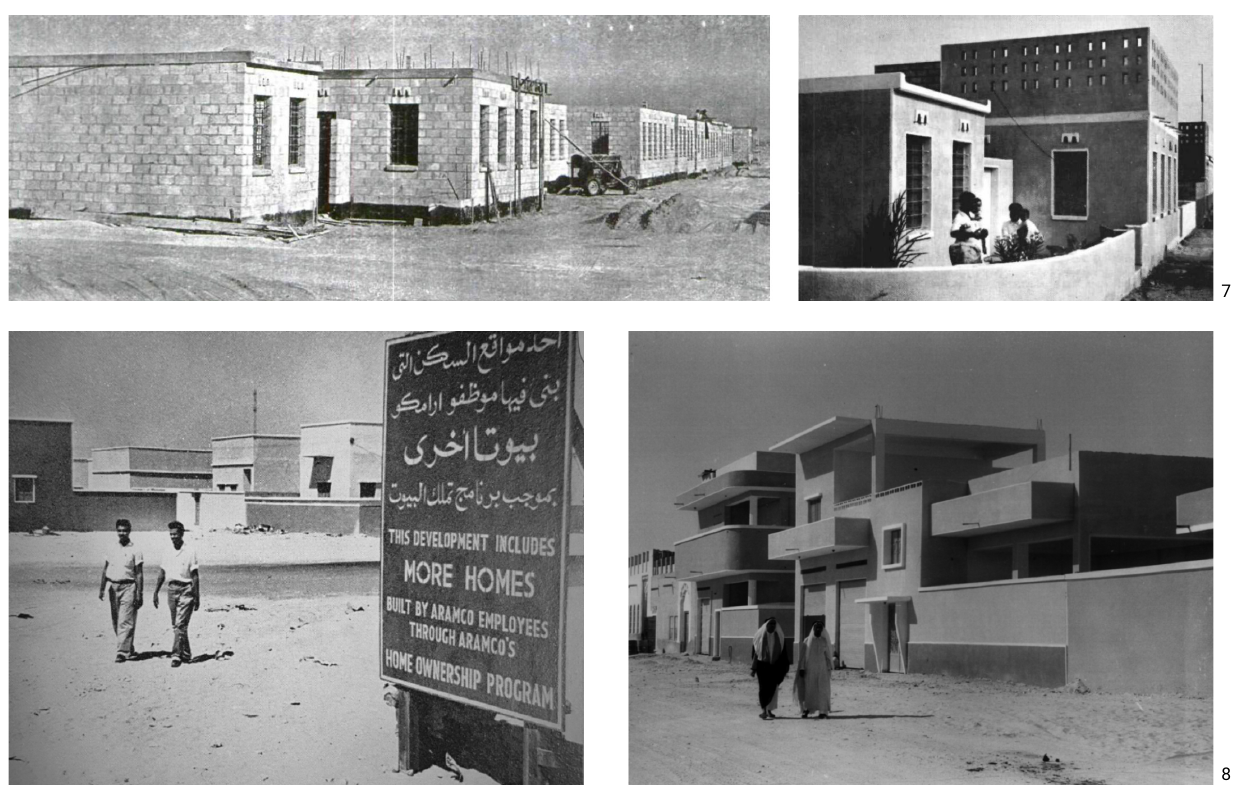
Aramco’s housing during and after construction in the mid- 1950s. Source: Saudi Aramco.